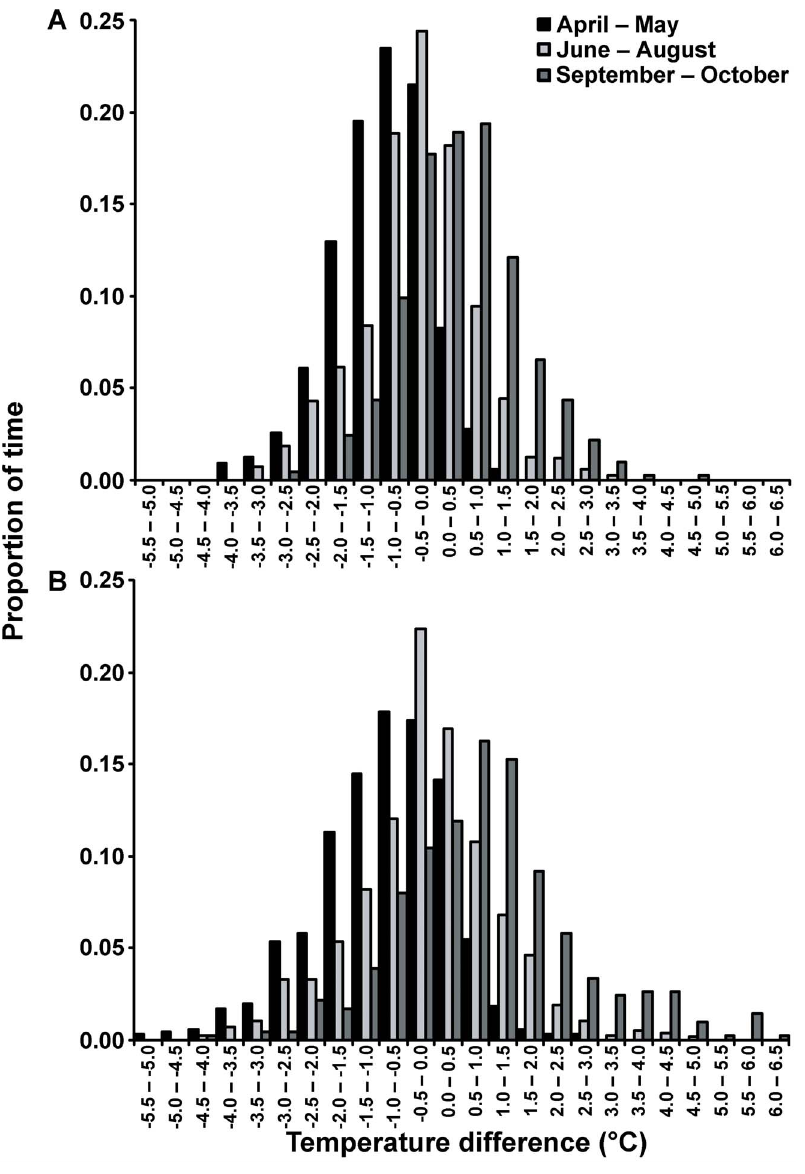
Figure 4. Microhabitat temperature differences. Histogram of temperature differences between nearshore and midflats (A) and nearshore and offshore (B) areas of Cape Rose Flats between 23 April 2007 and 14 October 2007. Negative temperature differences indicate nearshore areas were cooler and positive values indicate nearshore areas were warmer. All recorded temperature values were used for the construction of the histograms.